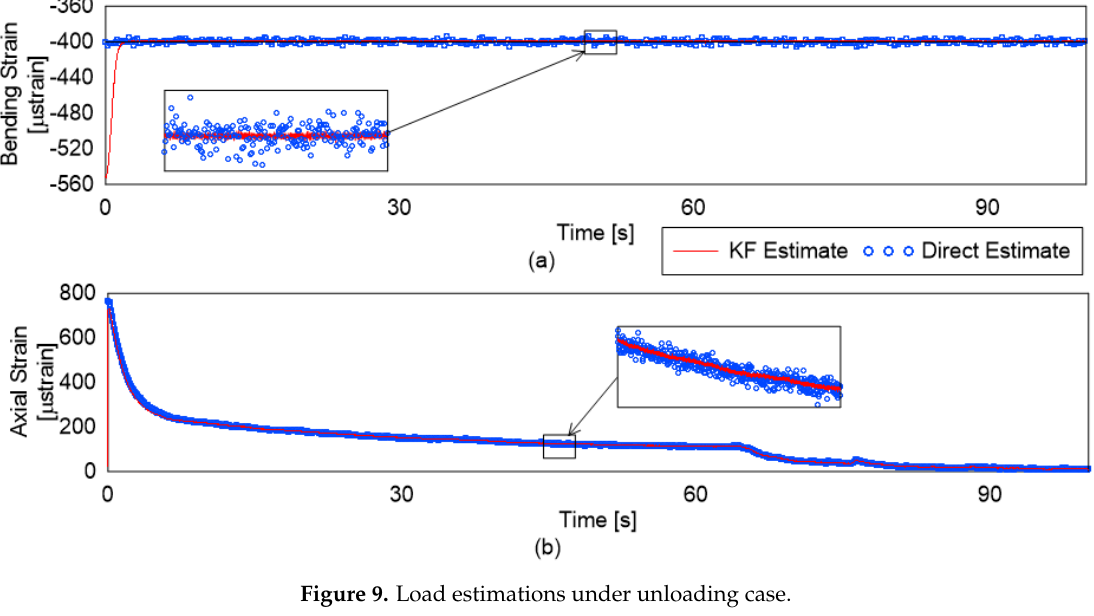
Figure 9. Load estimations under unloading case.